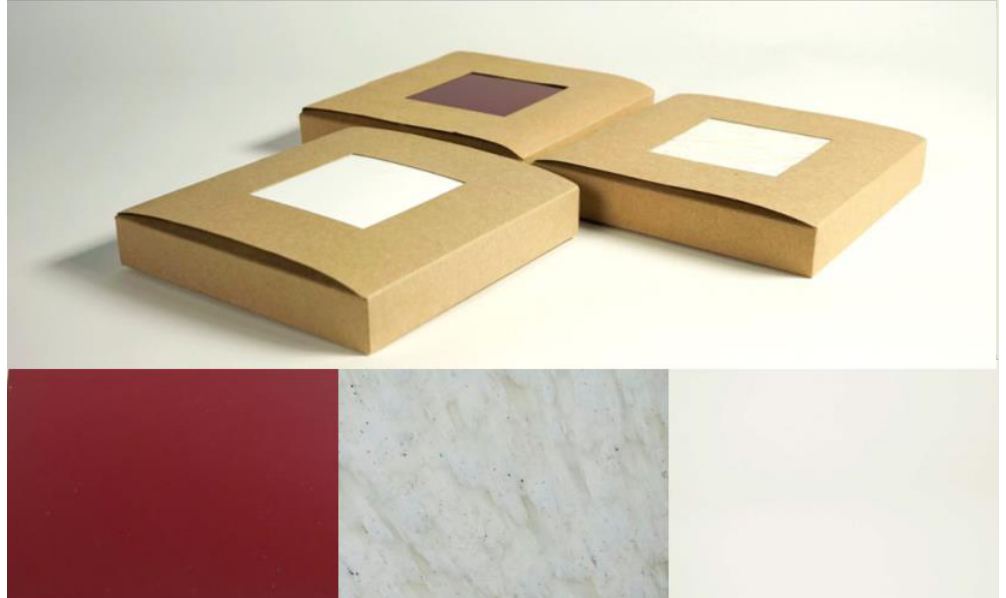
Figure 3. Material samples. In order from left to right: M1, raw material called Altuglas; M2, recycled material from Carpintería Plástica; and M3, recycled material called Syntal.